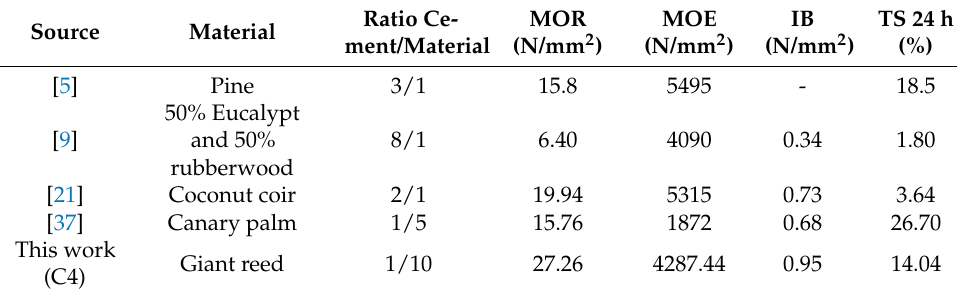
Table 7. Properties obtained with cement